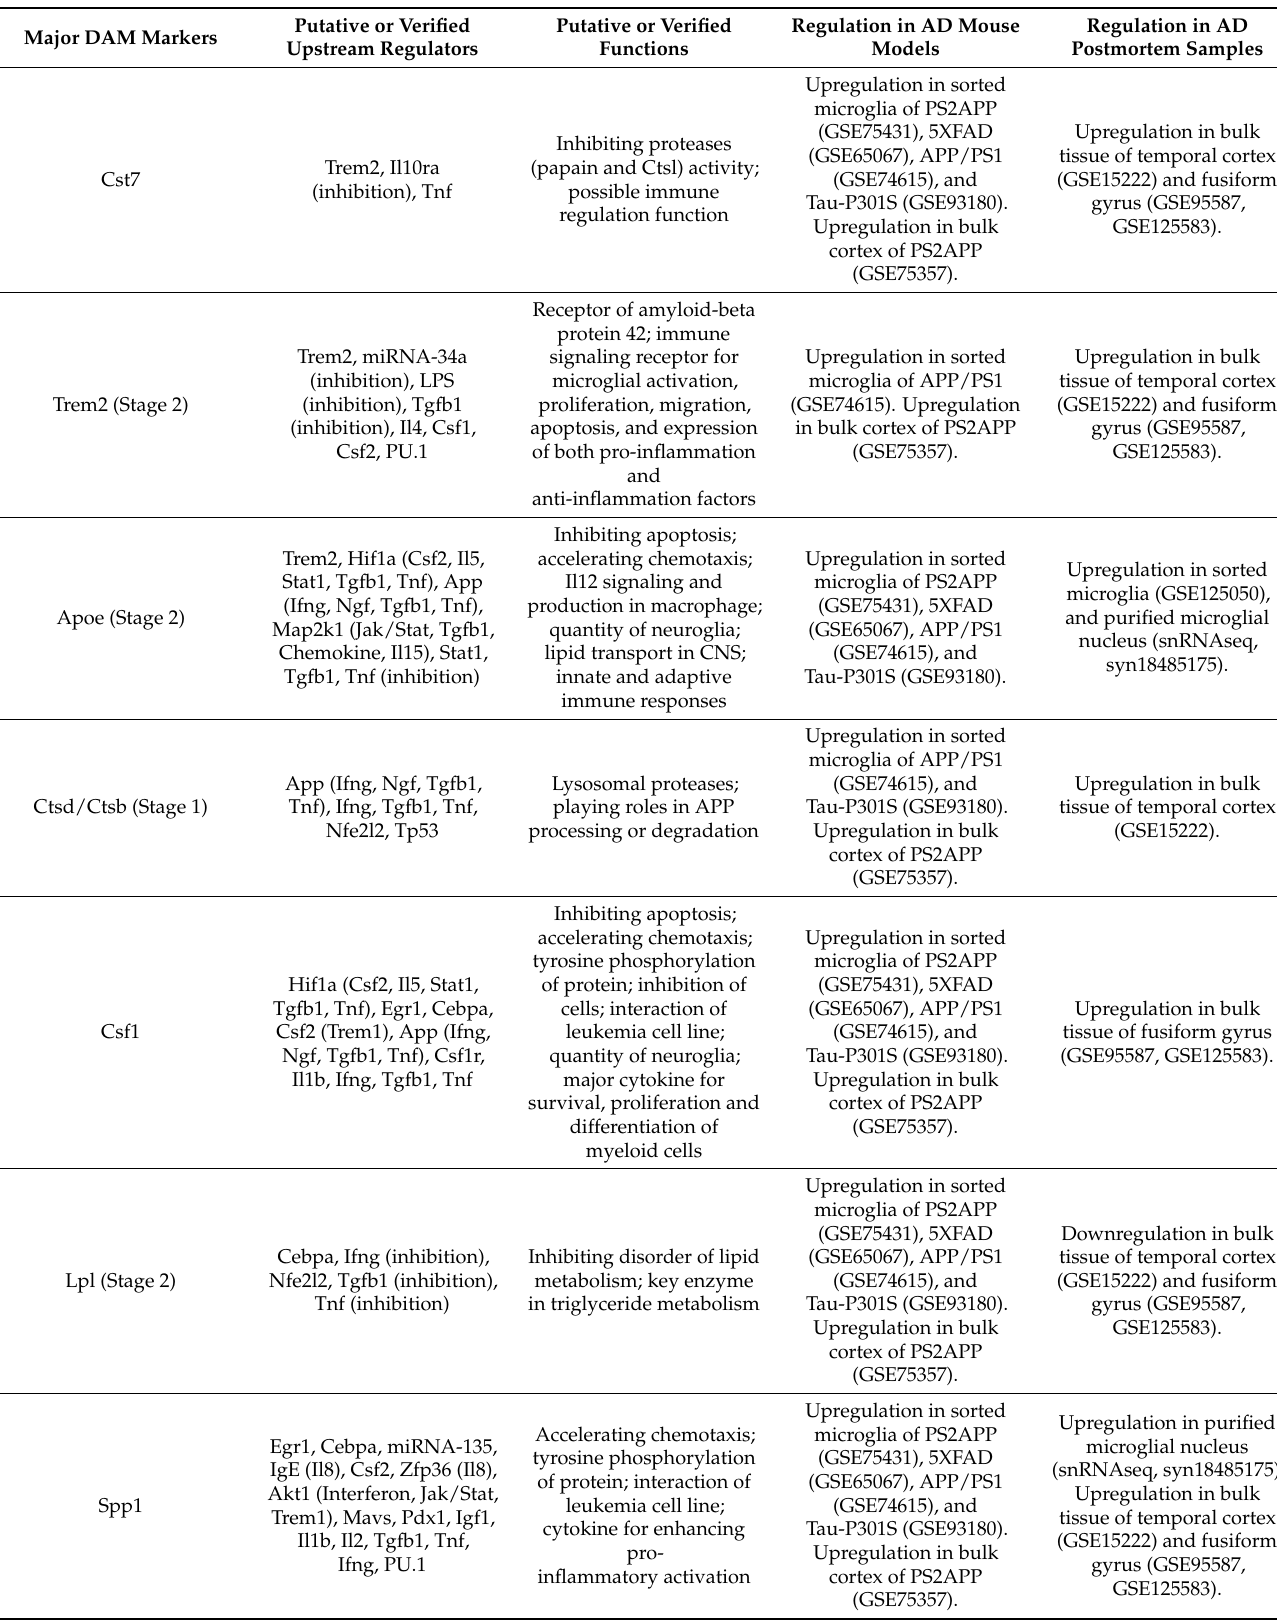
Table 1. Regulation and function of the major Trem2-dependent disease-associated microglia (DAM) markers. Major DAM